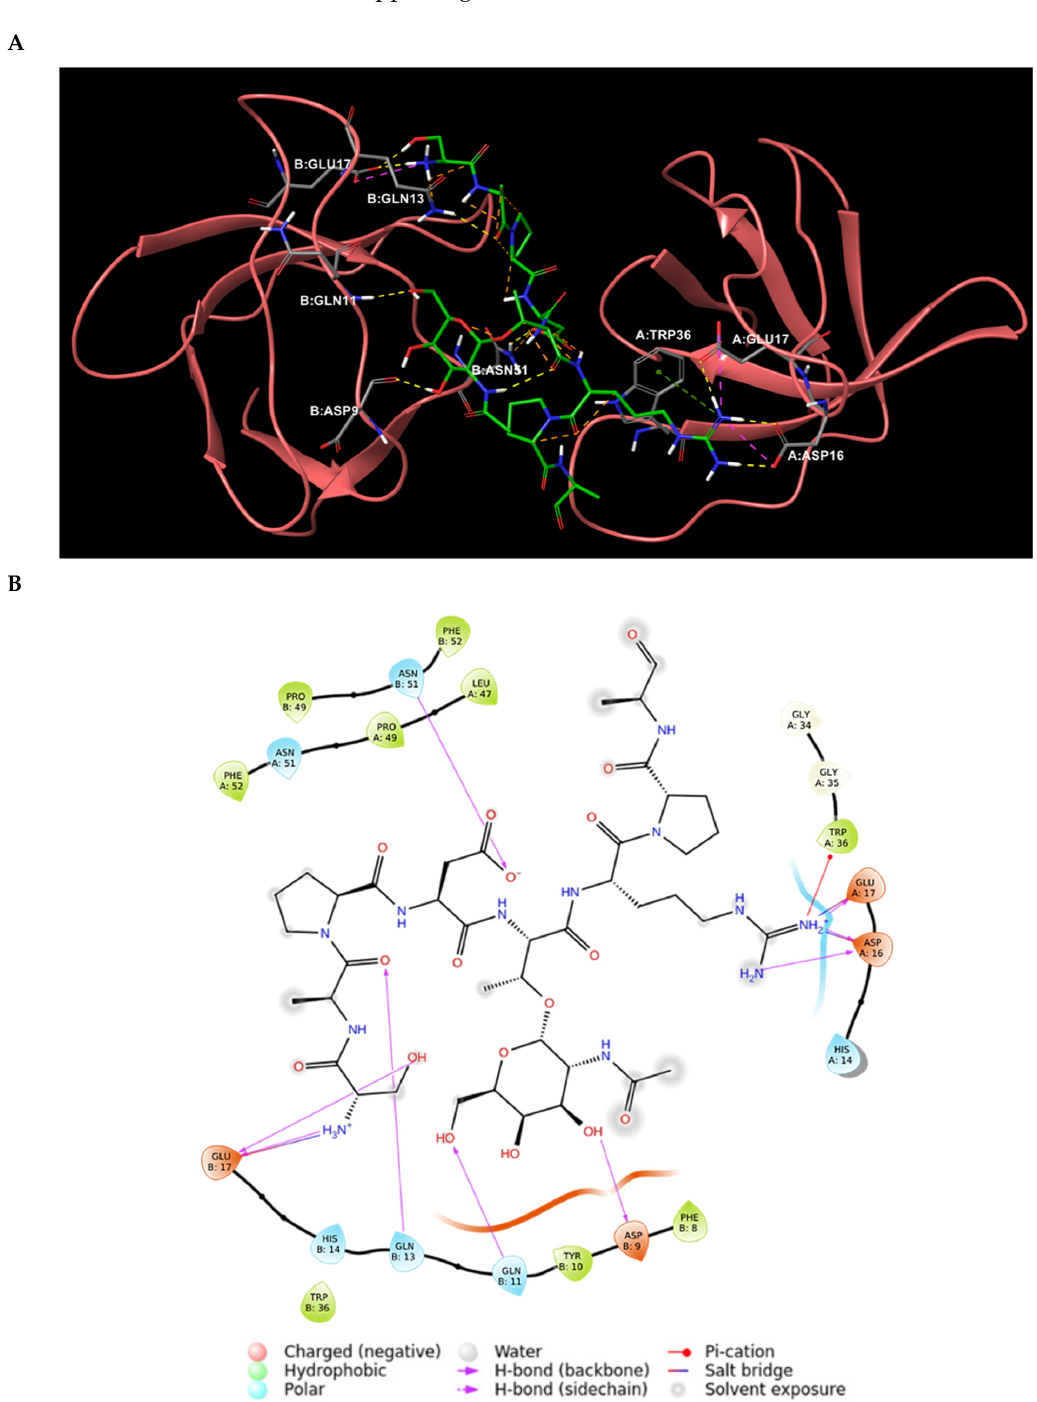
Figure 5. ( A ) Binding mode of MUC1 VNTR peptide CIN85 SH3 domains with the sequence GVTSAPDT*RPAP (filament with green stick bonds) retrieved from PDB 5OWP to CIN85 dimer from PDB 2BZ8 (orange structures), where chain A is represented on the right and chain B on the left. ( B ) MUC1 VNTR peptide interactions with SH3 domains residues of CIN85 from first prioritized protein-peptide docked complex.